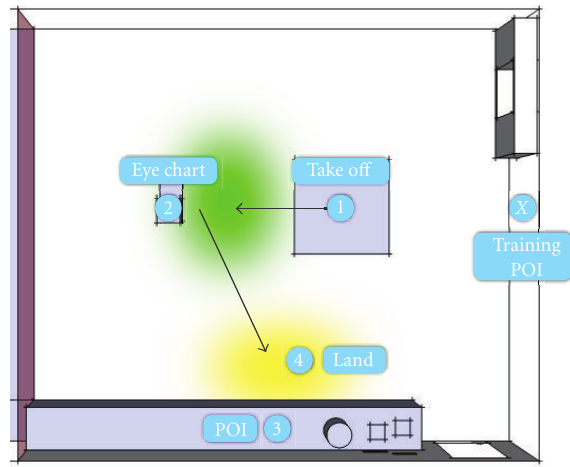
Figure 9: Annotated version of the map used in the study showing the layout of the